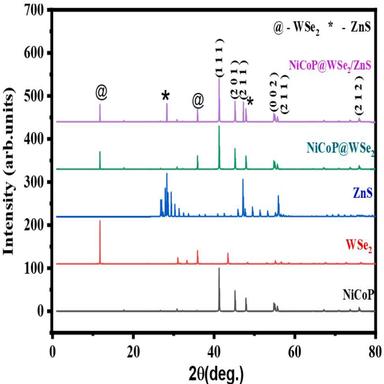
XRD pattern of NiCoP, NiCoP/WSe2 and NiCoP/WSe2@ZnS.